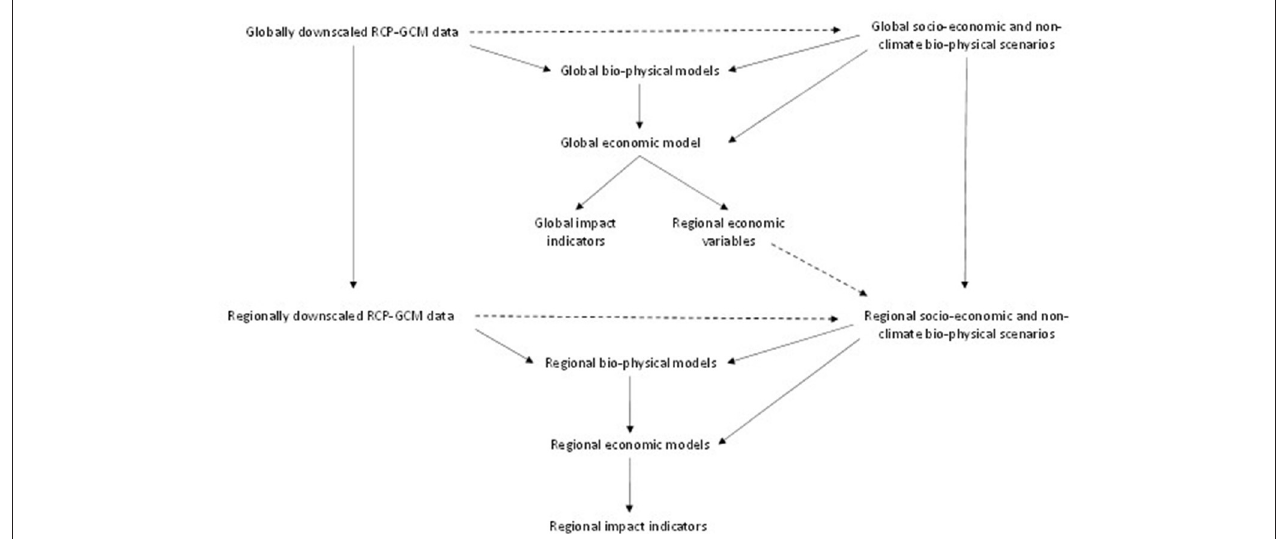
FIGURE 1 | Global and regional integrated assessment framework as implemented by the Agricultural Model Inter-comparison and Improvement Project (AgMIP). Solid arrows show linkages consistent with global pathways design in which global socio-economic scenarios are independent of global emission concentration pathways (RCPs). Dashed arrows indicate possible linkages from RCPs to global and regional socio-economic